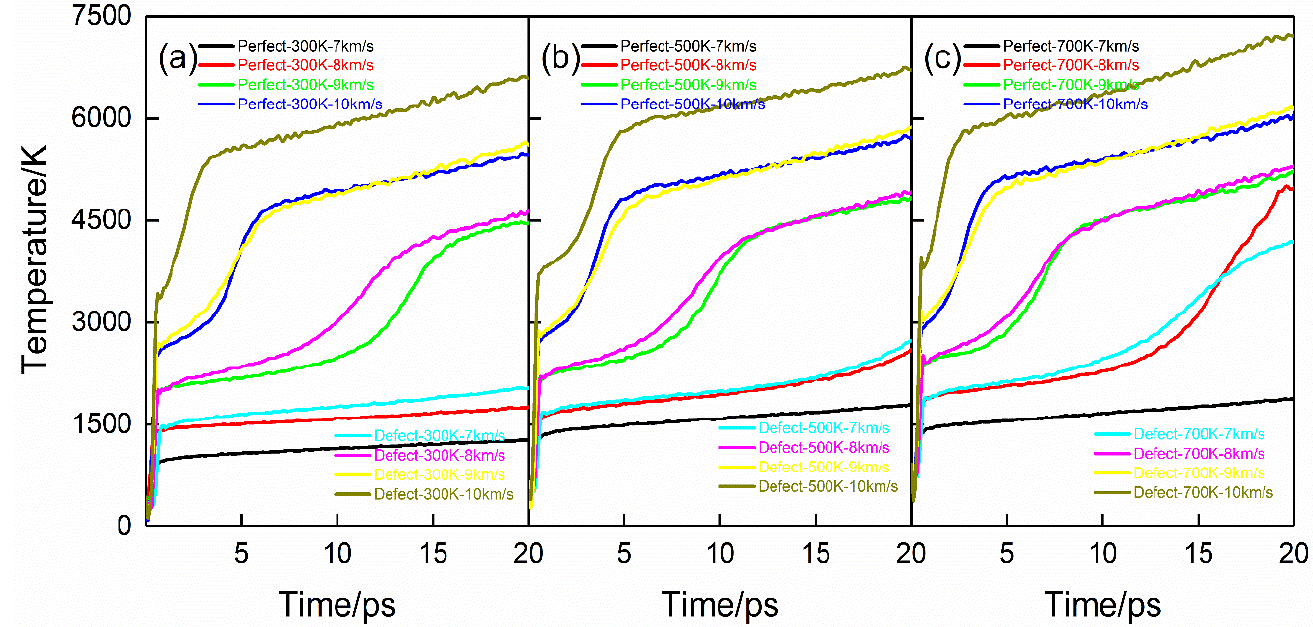
Figure 1. Temperature evolution curves for the shock compression. ( a – c ) correspond to PETN crystal with preheating temperatures of 300 K, 500 K, and 700 K.